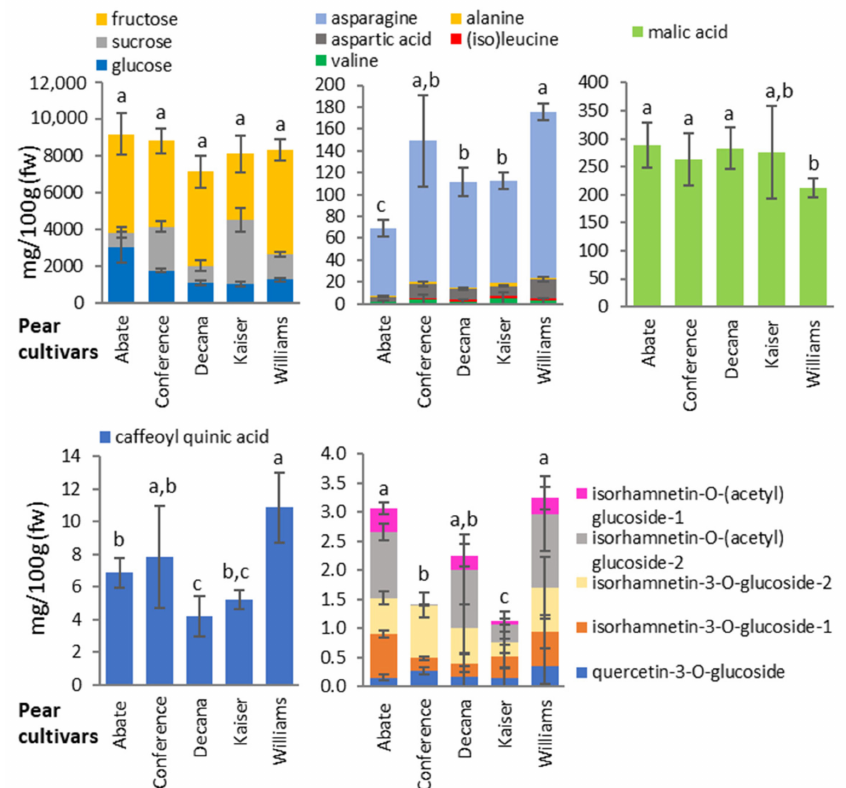
Figure 4. Quantities of the main primary and secondary metabolites in pear cultivars. Primary metabolites were quantified by NMR spectroscopy and secondary metabolites by HPLC-DAD. Data are expressed as mg/100 g of fresh weight (fw) and are means n = 3 samples representing two growing seasons ± standard deviations. Different letters on bars indicate that means referred to the sum of the molecules presented in each graph are significantly different among the pear cultivars according to post-hoc SNK-ANOVA ( p <